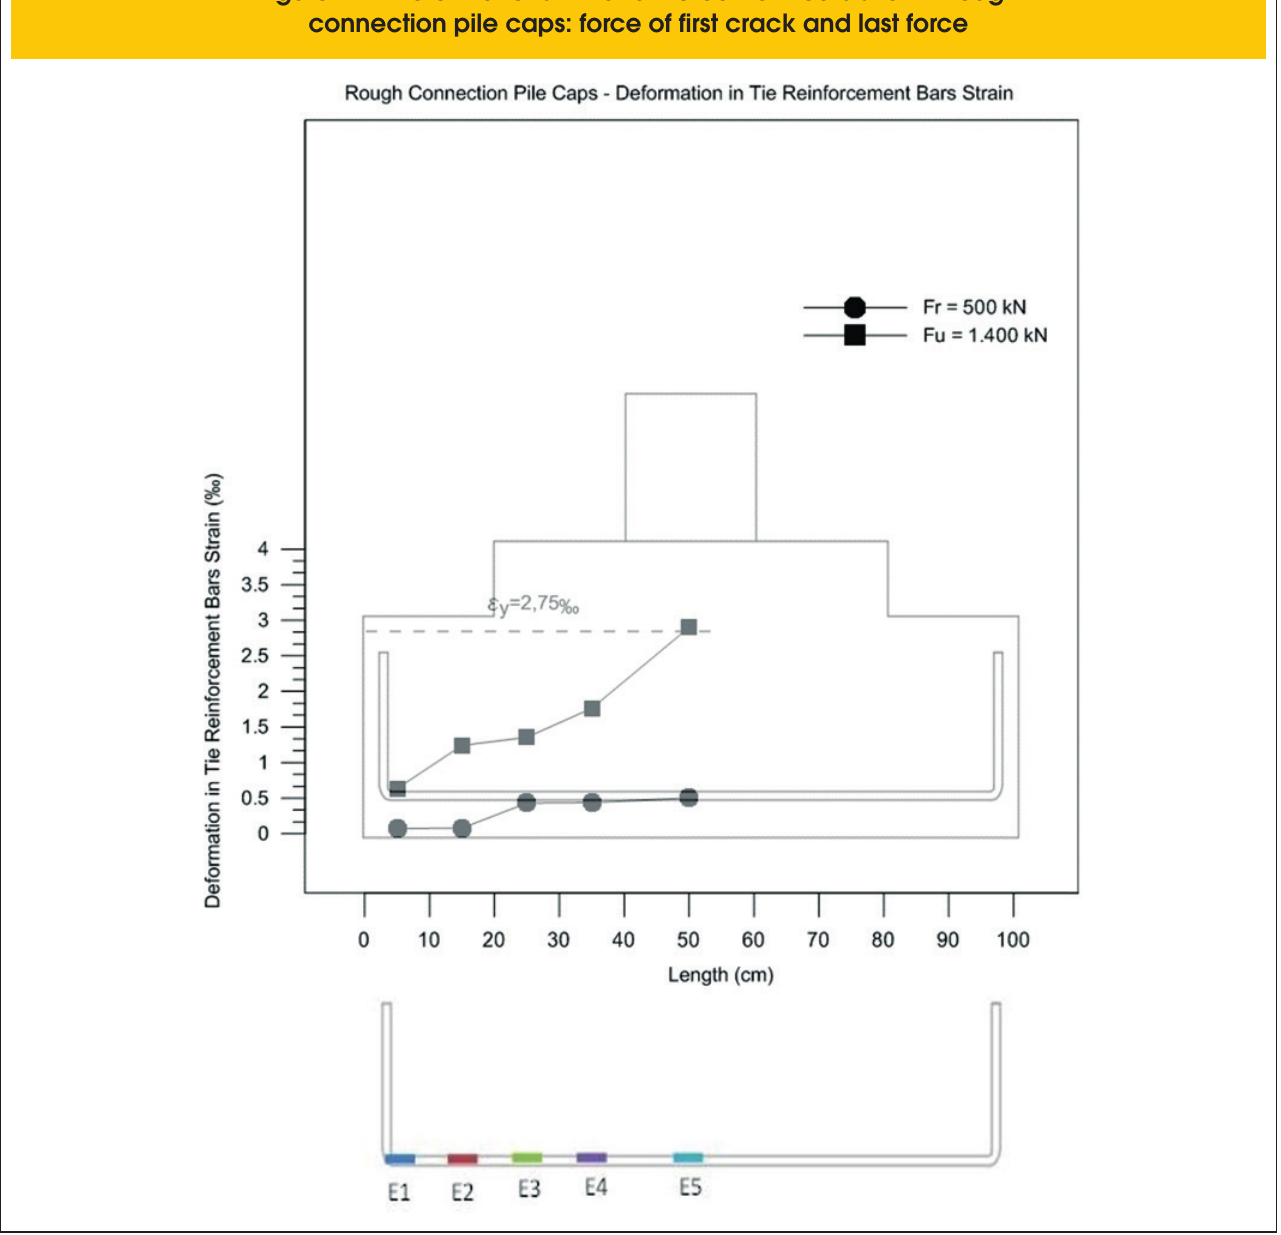
Figure 11 – Deformations in tie reinforcement bars strain – rough connection pile caps: force of first crack and last